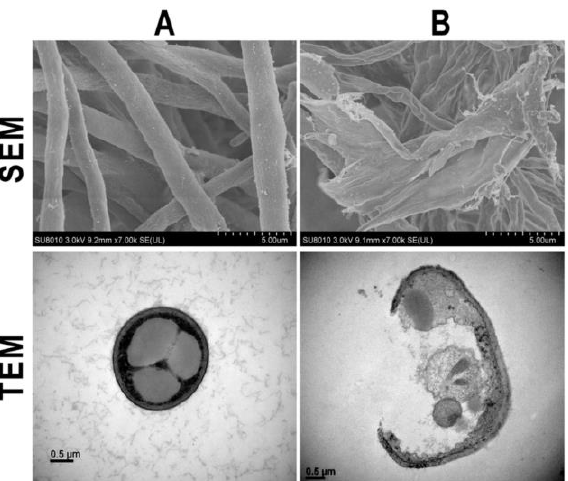
Figure 3. Microscopic images of SEM and TEM of F. graminearum in the absence ( A ) and presence ( B ) of the synthesized silver nanoparticle [116].